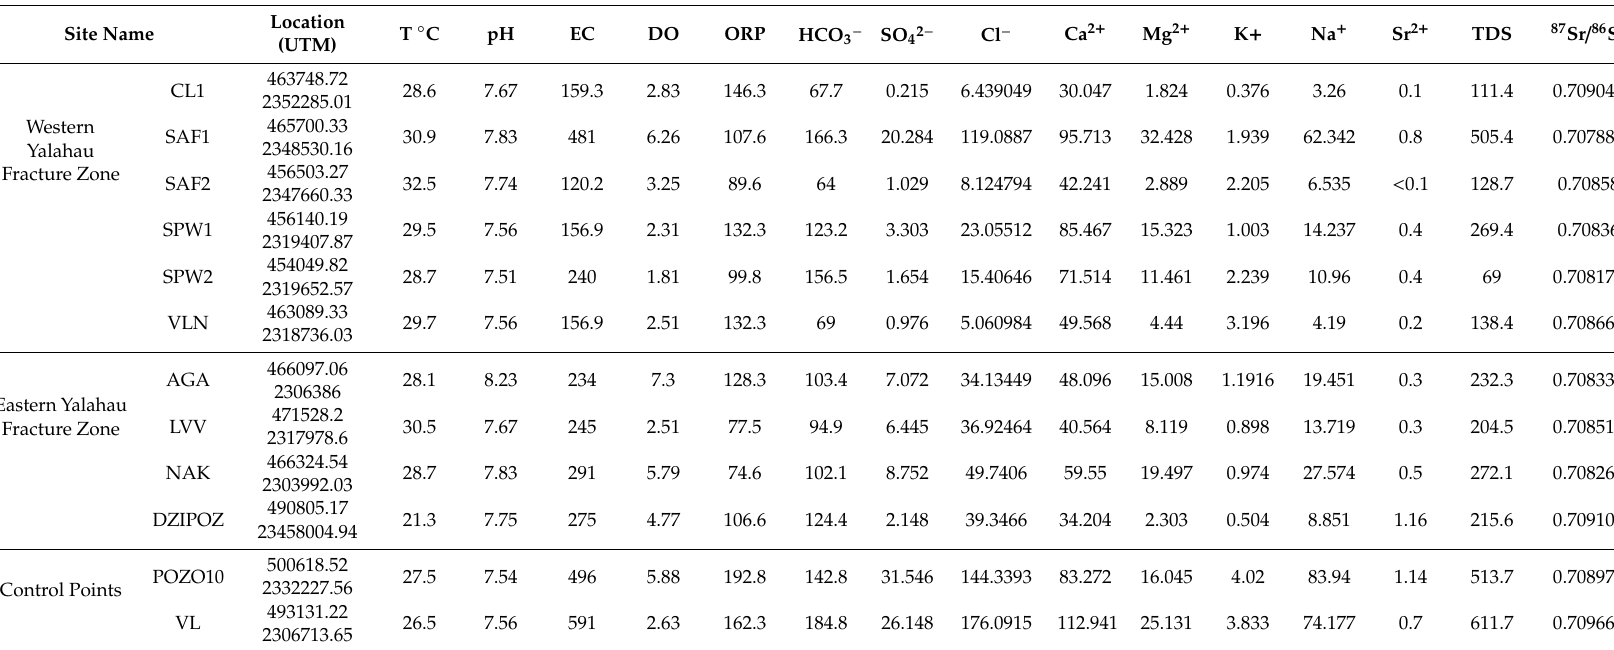
Table 1. Hydrogeochemical properties, major ions, and strontium isotopic composition of water samples. Units are (mg / L) for all ion geochemistry unless otherwise